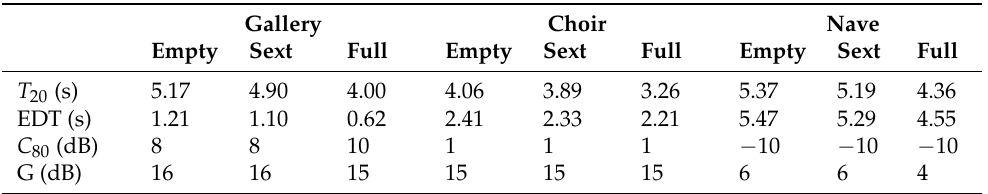
Table 1. Room acoustic parameters in various configurations of the reconstructed abbey. The values have been averaged according to ISO 3382-1:2009 [52]. Gallery Choir Nave Empty